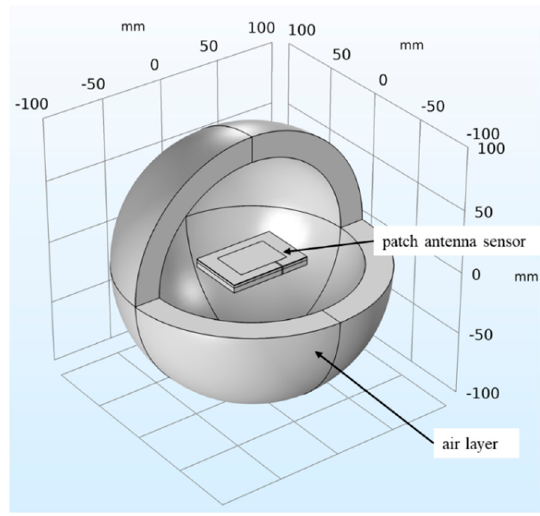
Figure 4. Simulation model of the patch antenna sensor.